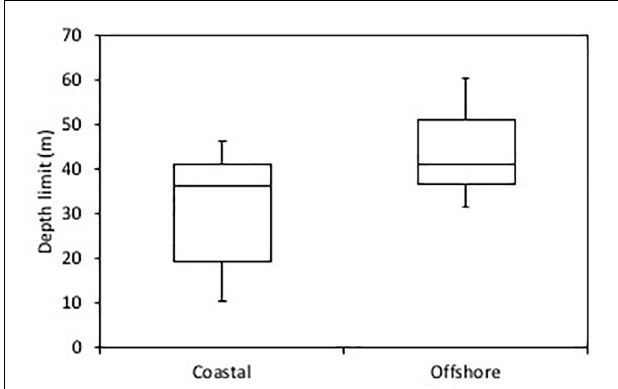
FIGURE 3 | Depth limits of kelp forests from the Disko Bay region, Greenland at 67–70 ◦ N in offshore sites (right panel) as compared with coastal sites (left panel). The box represents 25–75% percentiles, the central line is the median and the whiskers represent 10–90%